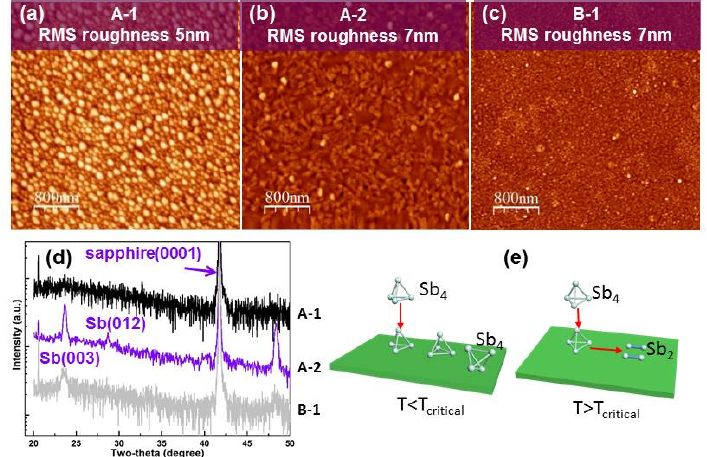
Figure 1. ( a – c ) Atomic force microscope (AFM) images of sample A-1, A-2, and B-1. ( d ) X-ray di ff raction (XRD) di ff ractogram of sample A-1, A-2, and B-1. ( e ) Proposed cracking mechanism of Sb 4 on the surface, showing the di ff erence when T < T critical and T > T critical